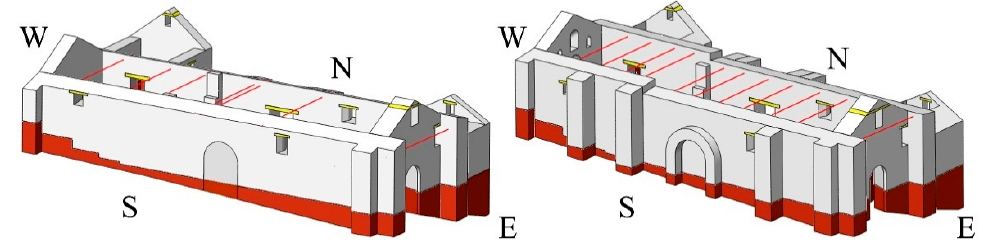
Figure 2. Three-dimensional model of the Church of Kuñotambo before ( left ) and after ( right ) strengthening.